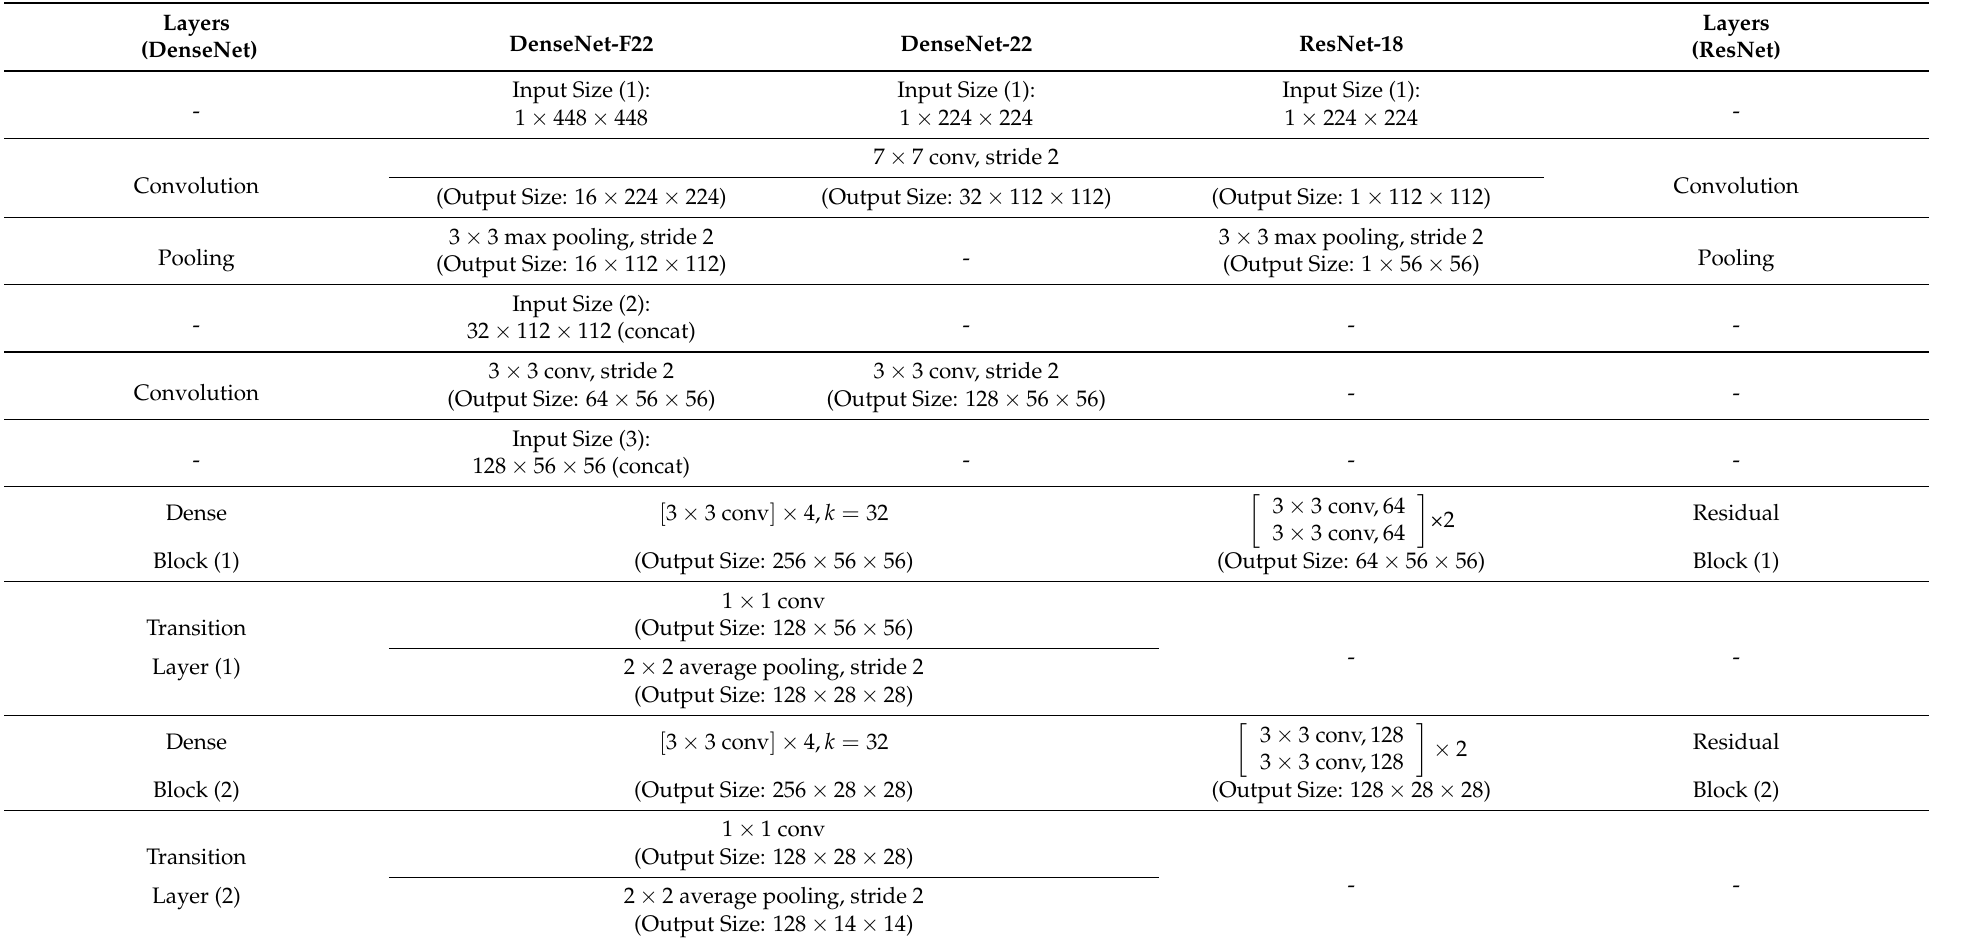
Table 2. Network architectures of DenseNet-F22, DenseNet-22 and ResNet-18. Layers DenseNet-F22 DenseNet-22 ResNet-18